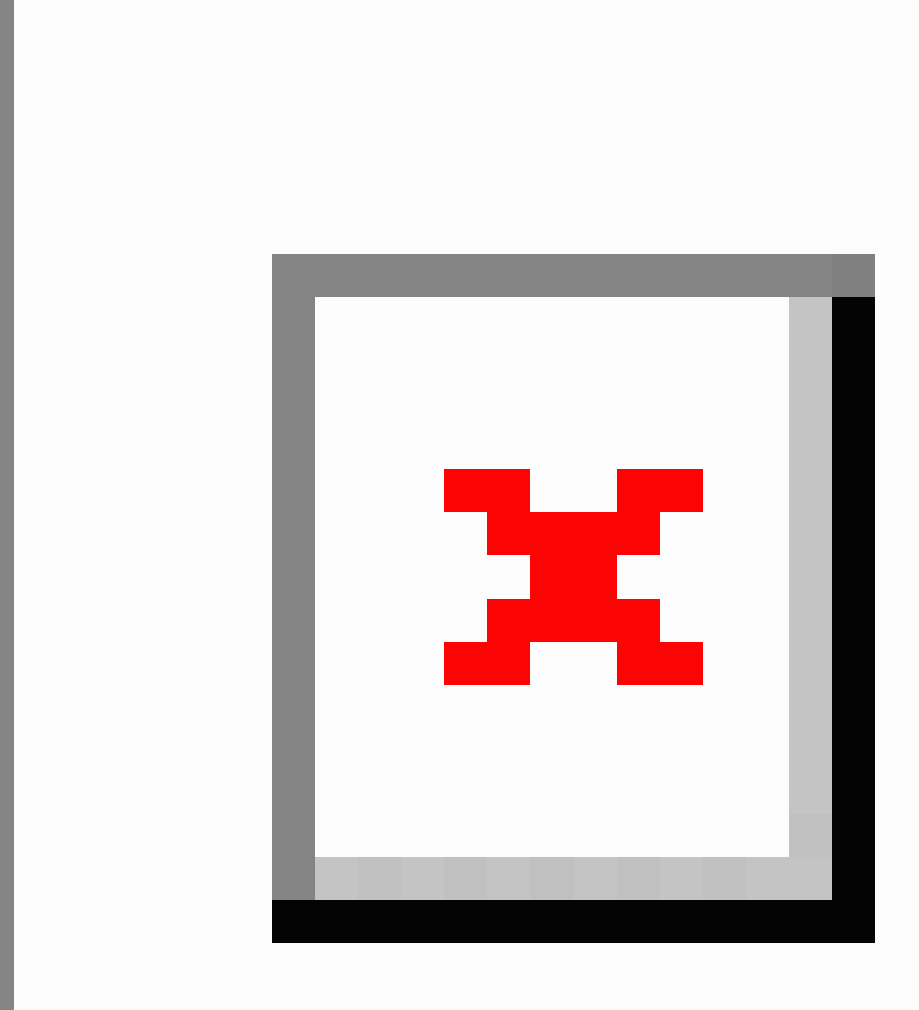
Figure 1. Start Strong ATL program